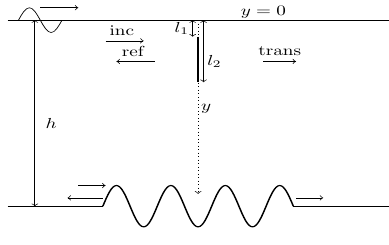
Figure 1. Physical representation of the